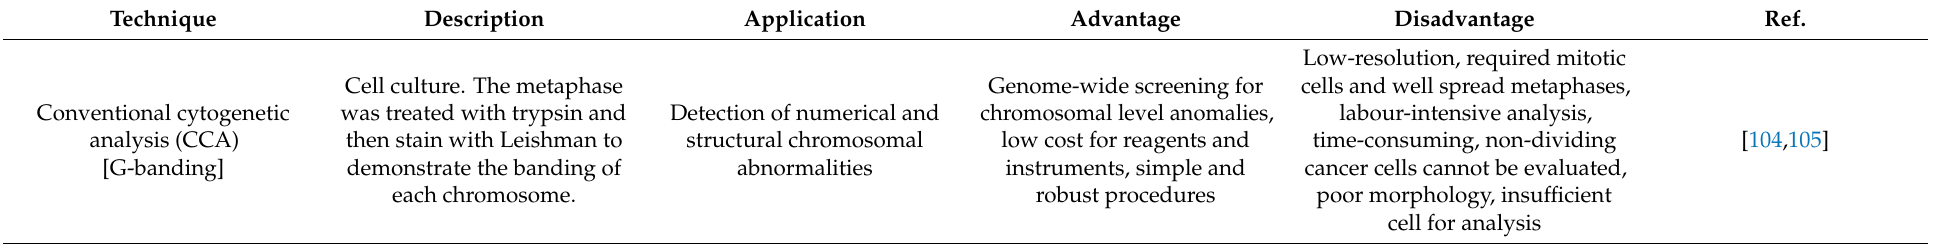
Table 4. Cytogenomics approaches for CLL